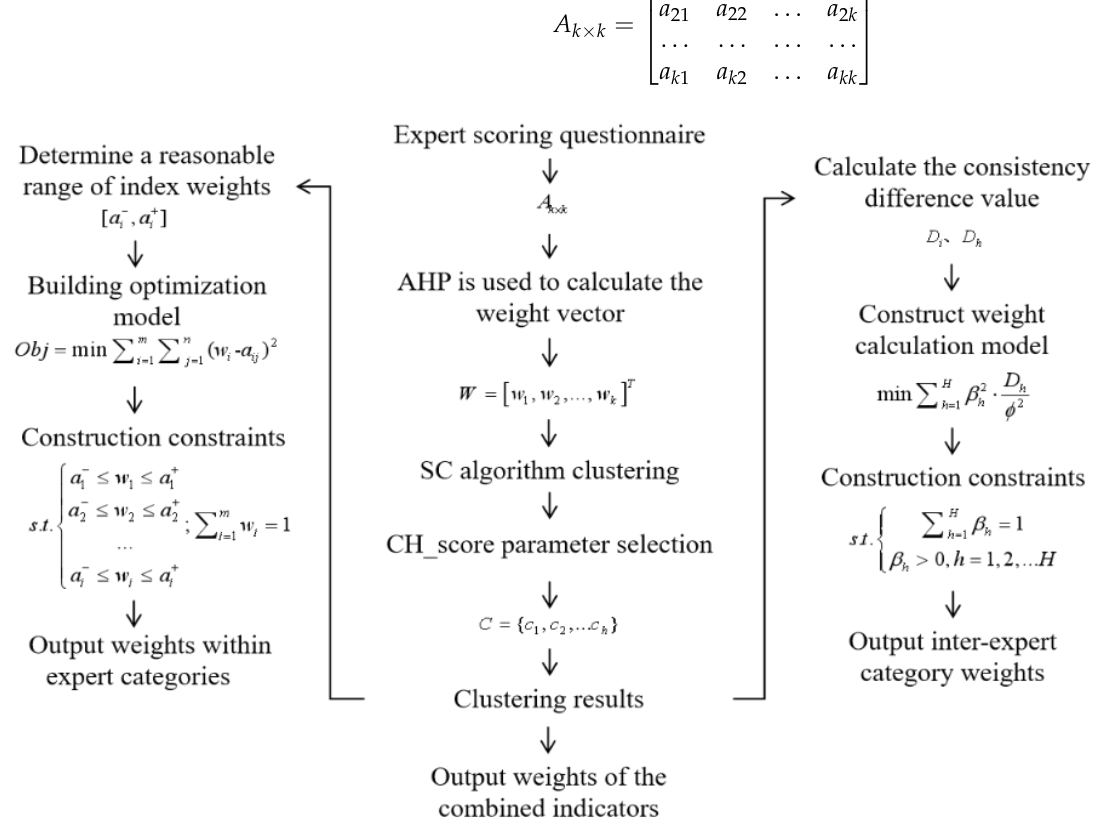
Figure 1. Flow of the construction of the index system.